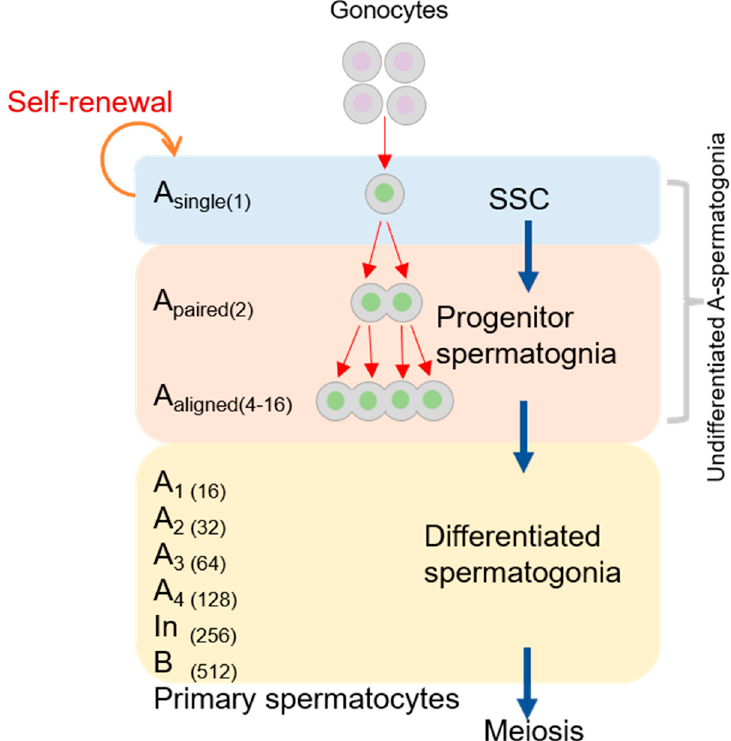
Figure 1. Characteristics of mammalian spermatogonial stem cell (SSC) development. Gray areas correspond to the cytoplasm, dark gray areas correspond to the cytomembrane, lavender and green areas correspond to the nucleus.